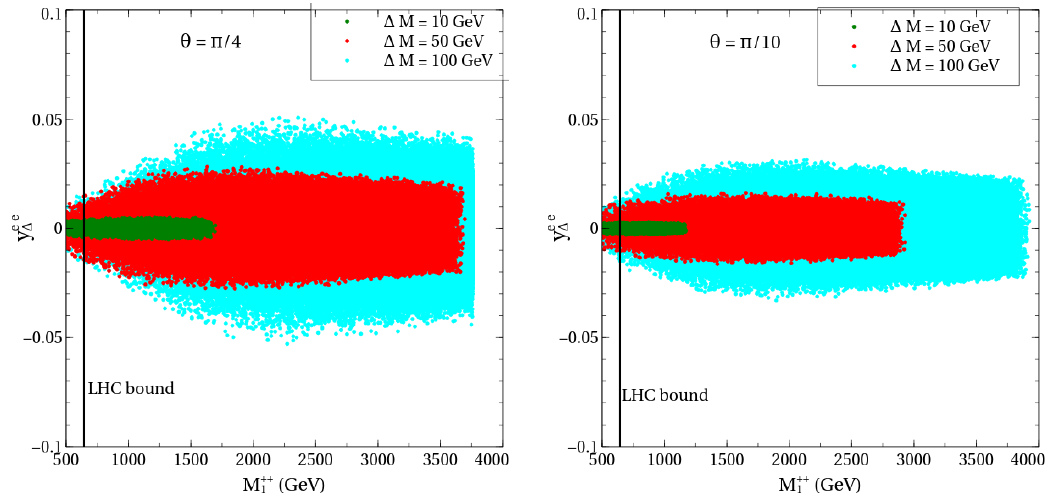
Figure 4 . The allowed parameter space maintaining (cid:1) a (cid:22) within its 2 (cid:27) range in the y ee for (cid:18) = (cid:25) (left) and (cid:25) (right). The color coding is explained in the legends. The M ++ 4 10 of the vertical line are disallowed by like-sign dilepton searches at the LHC.